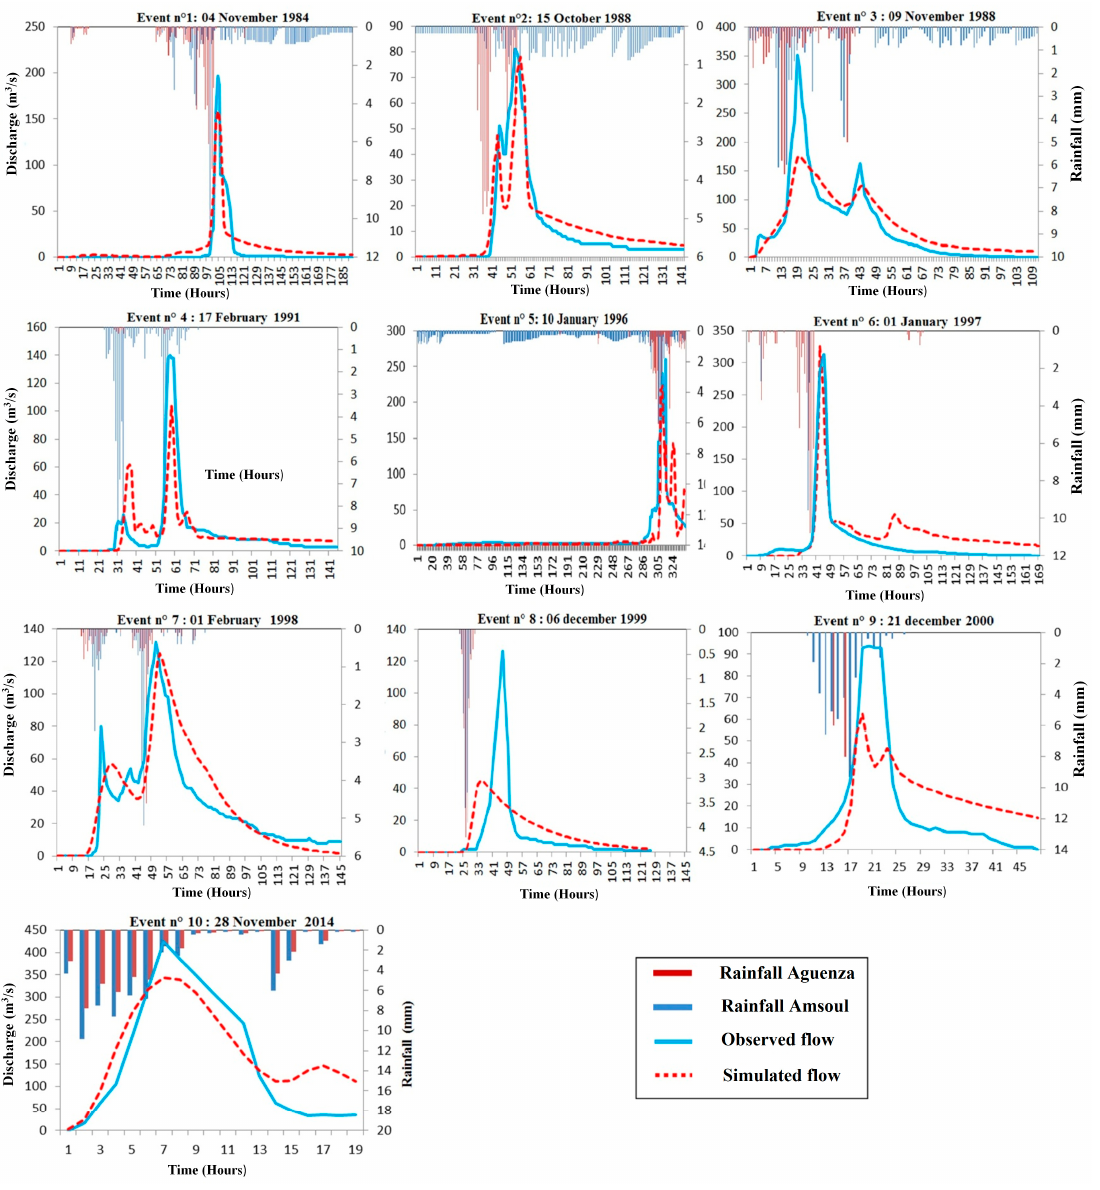
Figure 12. Simulation results for the ten events used for model calibration (events 1, 2, 3, 4, and 5) and validation (events 6, 7, 8, 9, and 10) (time step = 60min). Calibration consisted of adjusting the numerical values assigned to the model pa- Table 5. The parameters resulting from events calibration rameters to reproduce the observed response. In this study, a manual procedure was used by sensitivity analysis mainly for the three production function parameters (S, w, and ds) and then for the transfer function parameters (V 0 and K 0 ). The parameters of the coupled